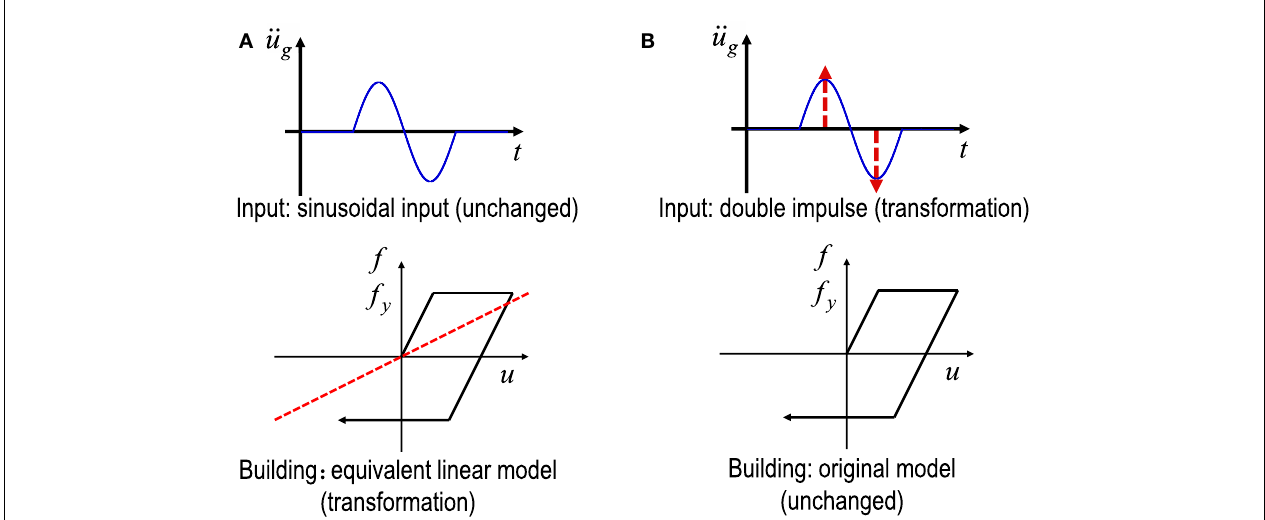
FIGURE 2 | Feature of method of input transformation against method of structural model transformation, (A) previous method (equivalent linearization of structural model for unchanged input), (B) new method (transformation of input into double impulse for unchanged structural model) (Kojima and Takewaki, 2016) .